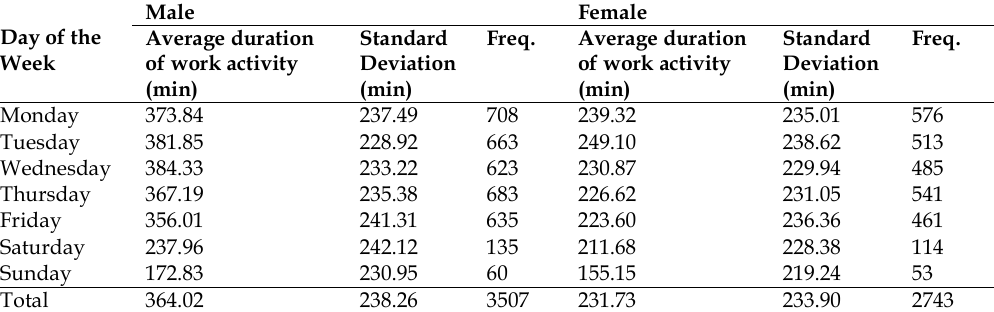
Table 5. Work duration statistics by day of the week and